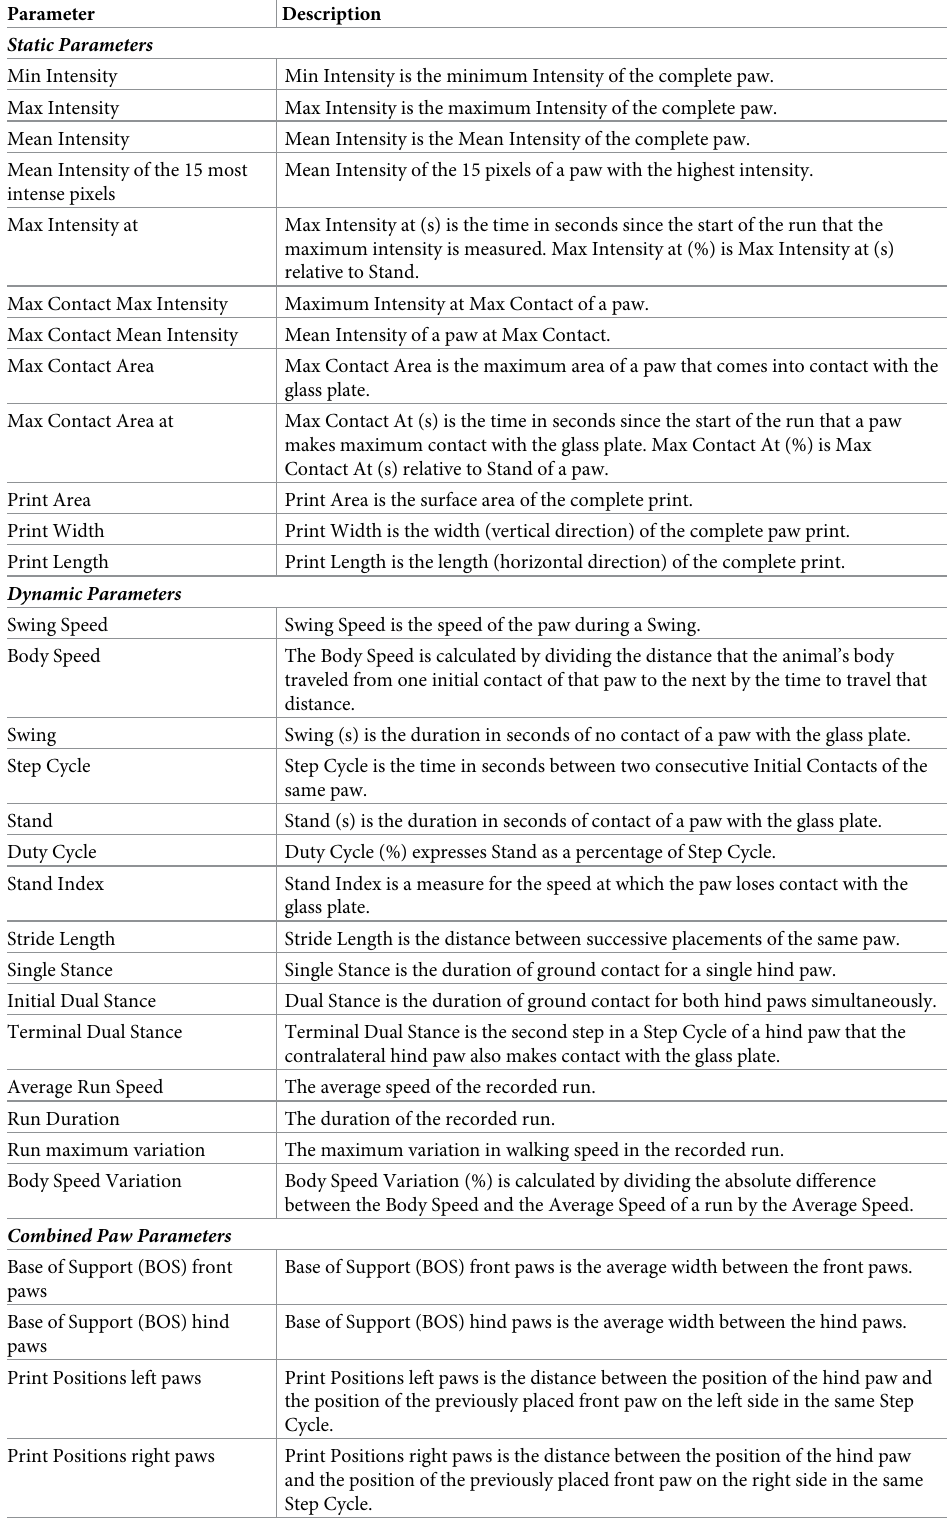
Table 1. Parameters automatically analyzed by the CatWalk XT 1